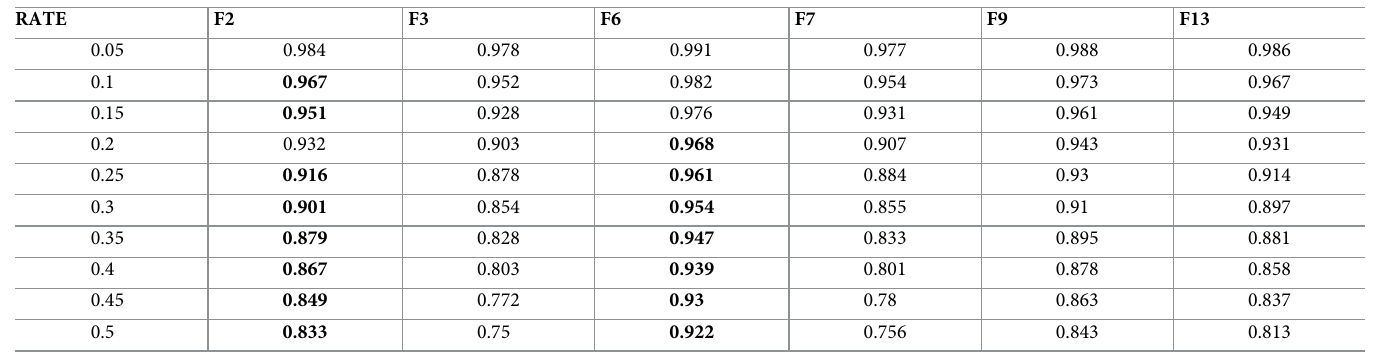
Table 13. Accuracy of MICE by feature.